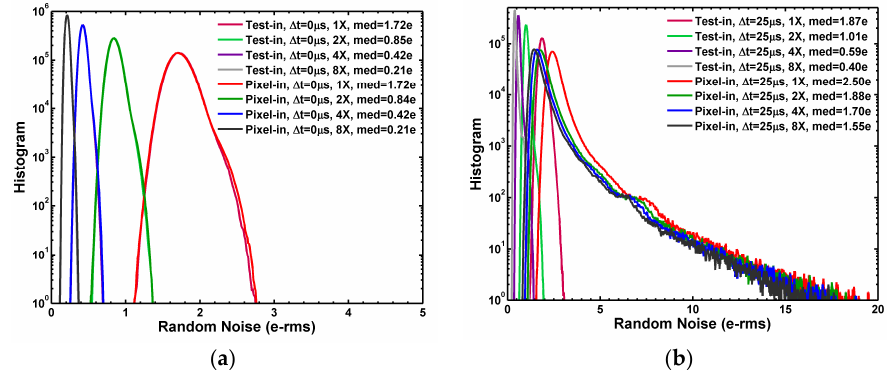
Figure 4. ( a ) The RN histogram measured at 1X, 2X, 4X, and 8X gains for the “test-in, Δ t = 0 μ s” and “pixel-in, Δ t = 0 μ s” modes. The distributions are tight Gaussian-like without noticeable long tails; ( b ) The RN histograms measured at 1X, 2X, 4X, and 8X gains for the “test-in, Δ t = 25 μ s” and “pixel-in, Δ t = 25 μ s” modes. Among the 4 operation modes, only the histograms of the “pixel-in, Δ t = 25 μ s” mode show significant long tails.